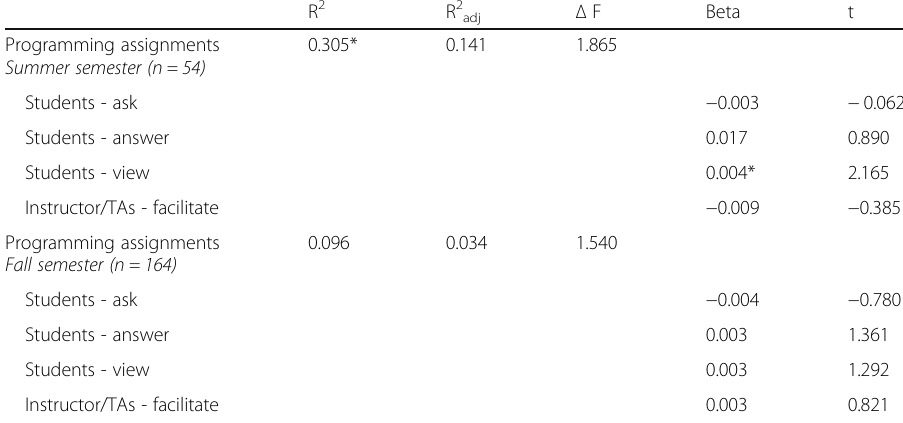
Table 5 Blockwise regression analysis of student online Q & A behaviors on their performance of programming assignments